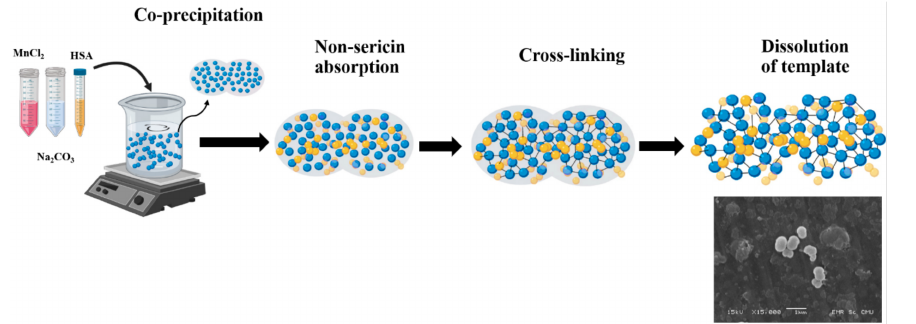
Figure 1. Fabrication procedure of non-sericin loaded human serum albumin micro particles (NS- HSA MPs) using the coprecipitation crosslinking dissolution technique